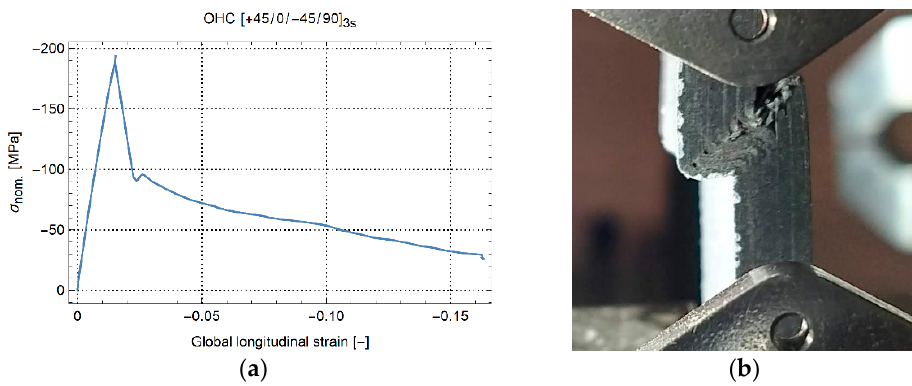
Figure 4. Compression of a specimen with layup [+45/0/ − 45/90] 3s . ( a ) Nominal stress–global strain ( b ) side view at − 0.16 [-] strain.